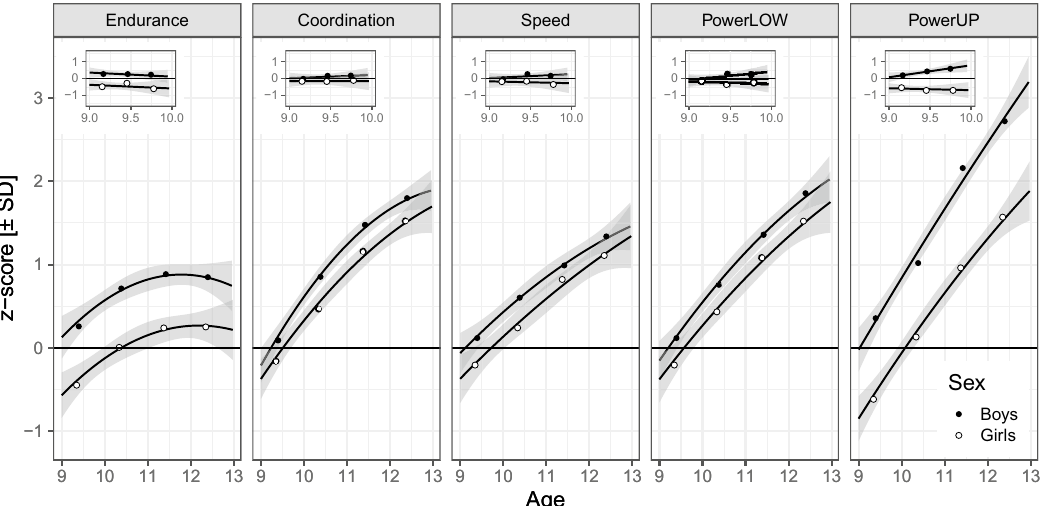
Figure 1. Physical fitness curves of a longitudinal sample of 240 German boys (closed circles) and girls (open circles) followed from age 9 to 12 years for endurance = cardiorespiratory endurance (i.e., 9 min run test), coordination (i.e., running in a star like pattern), speed (i.e., 50-m linear sprint test), powerLOW = power of lower limbs (i.e., triple hop test), and powerUP = power of upper limbs (i.e., ball push test). The insets show for each test score the regression on age for the first assessment when children were between 9.00 and 9.99 years old. Also shown are the means for groups of boys and girls binned into three age groups (i.e., 9.00–9.33; 9.34–9.66; 9.67–9.99). Error bands are 95% CIs. Data are from Golle et al. 6